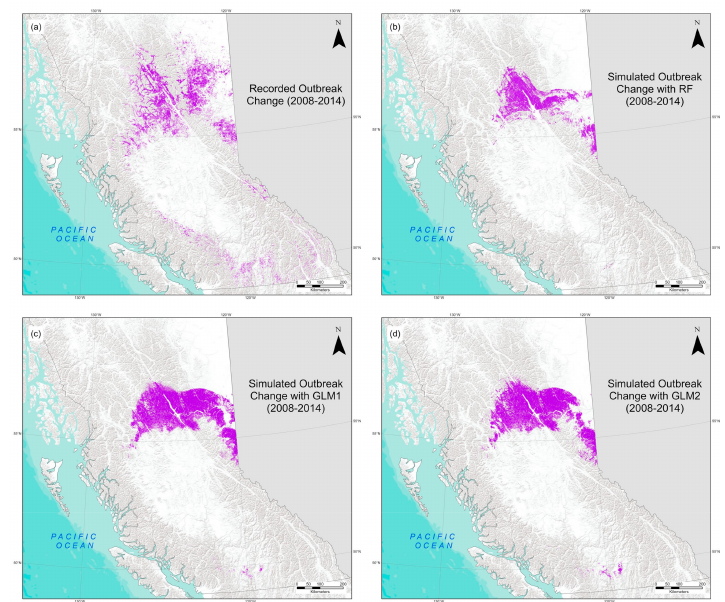
Figure 3. Comparison of model simulations with reference observations of changes in the study area from 2008 to 2014. ( a ) Mountain pine beetle outbreak change in British Columbia (BC) recorded by satellite imagery and aerial surveys; mountain pine beetle outbreak change simulated with algorithms: ( b ) random forests (RF), ( c ) binomial regression (GLM1), ( d ) binomial regression with parabolic elevation (GLM2).